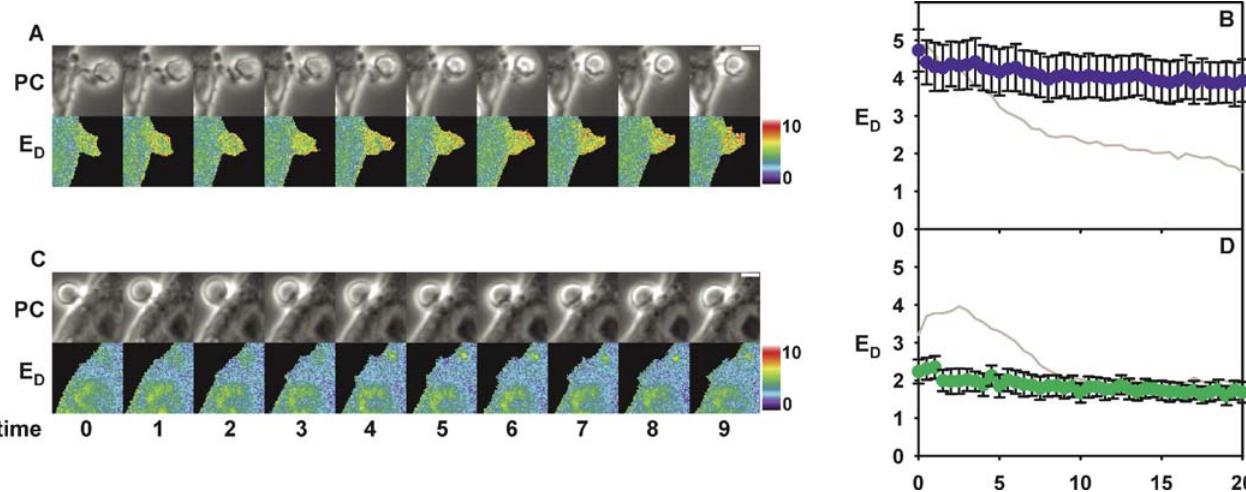
Figure 4. Activation of ARF6 and ARF1 during Phagocytosis in Macrophages Pretreated with LY294002 Macrophages co-expressing ARF6-CFP or ARF1-CFP with YFP-NGAT were treated with LY294002 for 30 min to inhibit PI-3K. (A) Phase contrast and E D images from an RAW264.7 macrophage expressing ARF6-CFP and YFP-NGAT. Binding of the IgG-opsonized erythrocyte led to activation of ARF6-CFP, but the phagosome never closed, and ARF6-CFP was not deactivated. (B) The particle-tracking analysis for ten phagosomes from cells co-expressing ARF6-CFP and YFP-NGAT indicated that the magnitude of ARF6 activation in response to Fc c R ligation was not reduced, but ARF6 deactivation could not proceed in the presence of PI-3K inhibitor. (C) Phase contrast and E D images from a macrophage expressing ARF1-CFP and YFP-NGAT did not demonstrate a phagosome-localized activation of ARF1 in the presence of LY294002. However, ARF1-CFP activation at the Golgi apparatus appeared to be unaffected (crescent-shaped region of high E D near the nucleus). (D) Measurement of ARF1 activation in LY294002 by particle-tracking analysis of nine phagosomes showed that a consistent but low level of ARF1 was bound to GTP at phagocytic cups; these macrophages did not display the transient, localized activation of ARF1 seen in control cells not treated with LY294002. Gray lines in (B) and (D) are the activation profiles in the absence of LY294002 for ARF6 and ARF1, respectively, taken from Figure 3B and 3D. Error bars represent 6 SEM. Scale bars in (A) and (C) are 3 l m. DOI: